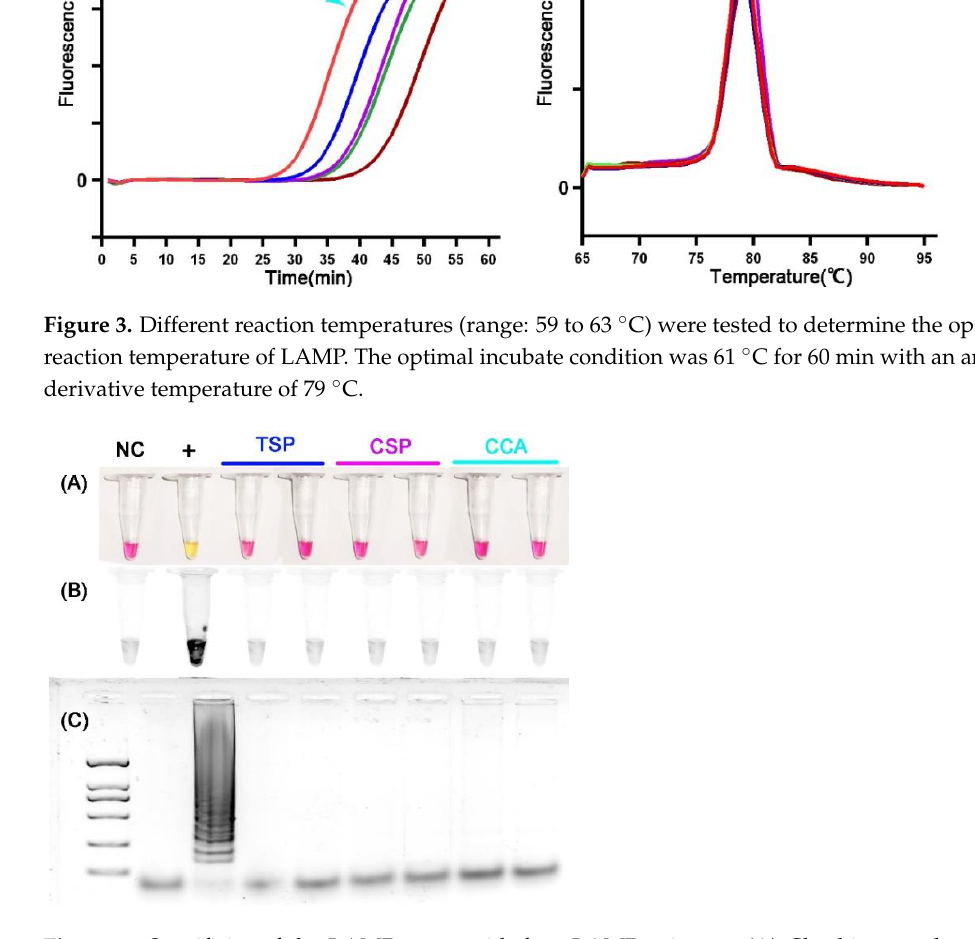
Figure 4 . Specificity of the LAMP assay with four LAMP primers. ( A ) Checking results under visible light, ( B ) checking results under ultraviolet light with GelRed and ( C ) checking results by gel electrophoresis. NC: negative control, +: T. japonensis , TSP: Thecodiplosis sp., CSP: Contarinia sp., CCA: C. caryafloralis .